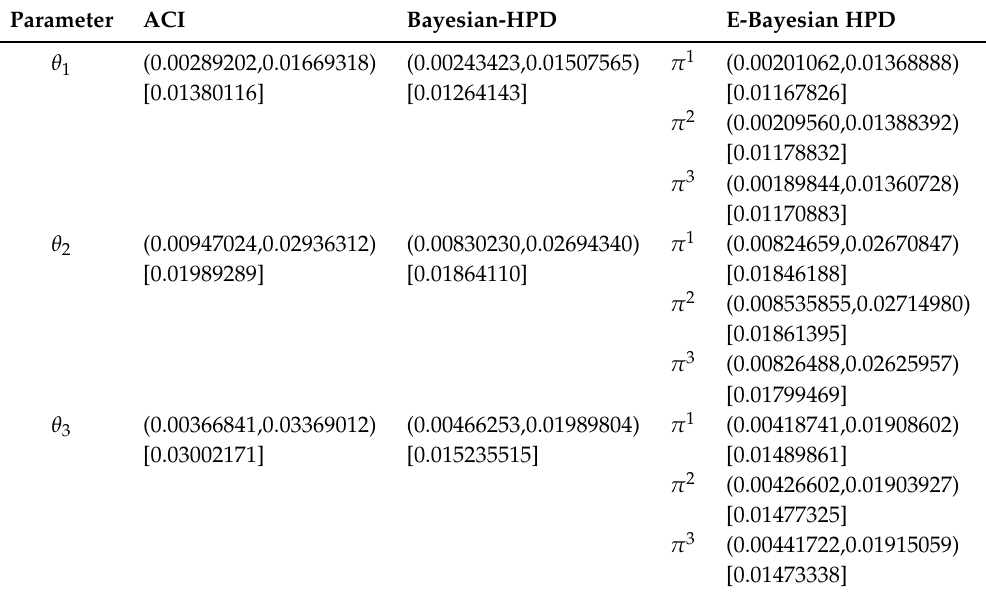
Table 14. Interval estimates for unknown parameters under HIV infection competing risk